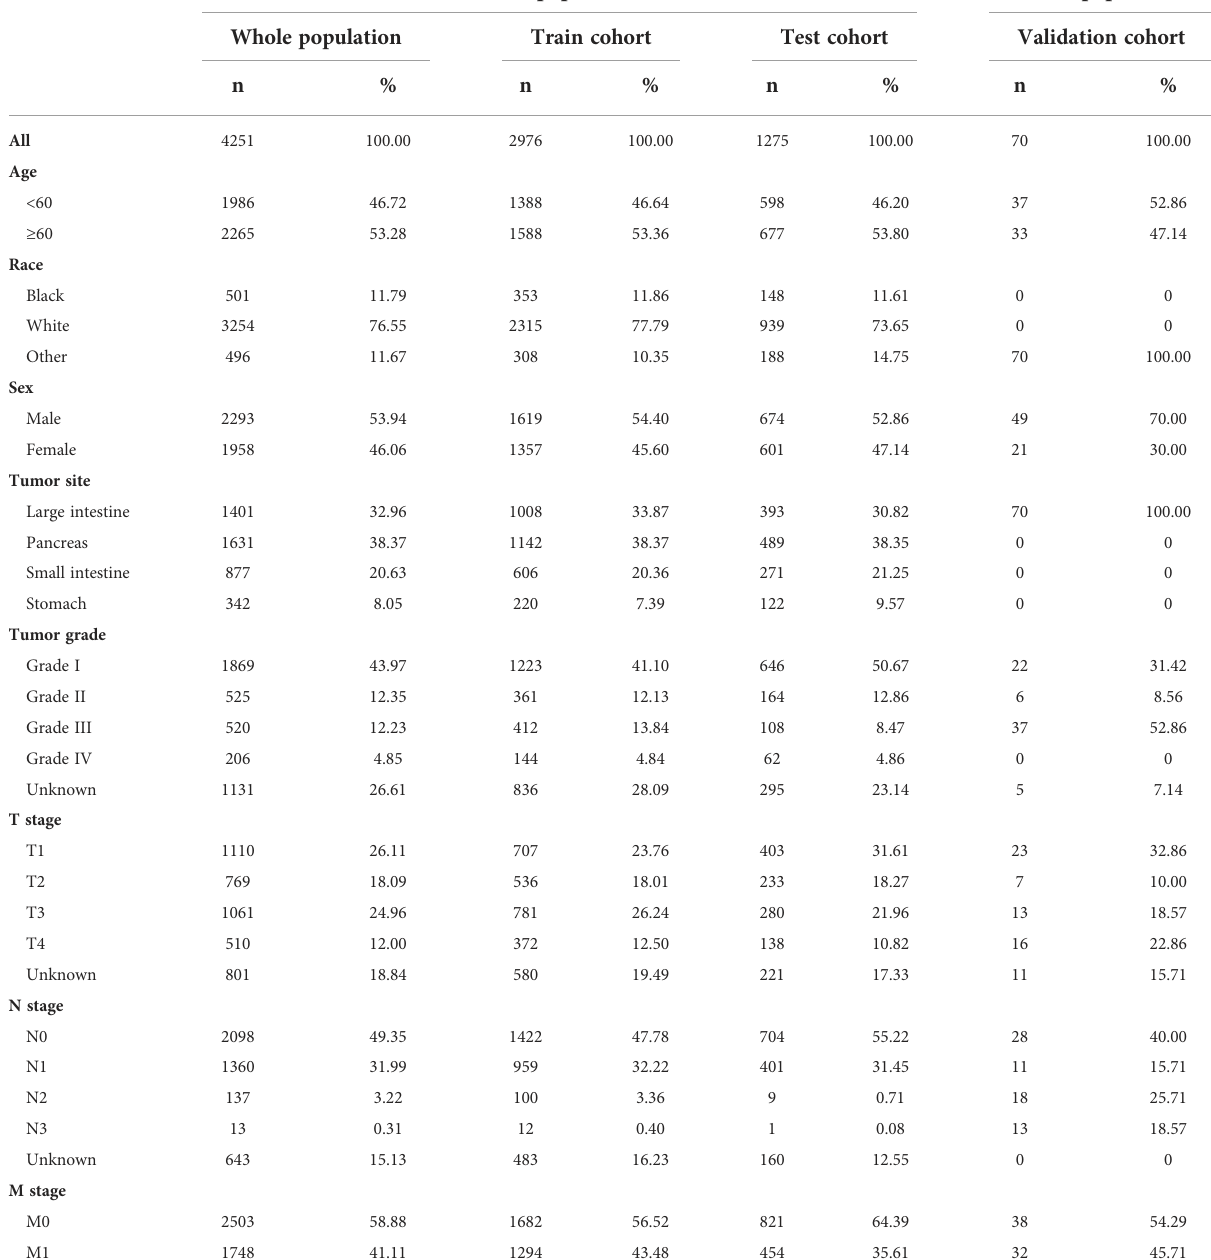
TABLE 1 Clinicopathological and demographic characteristics of patients with GEP-NECs.